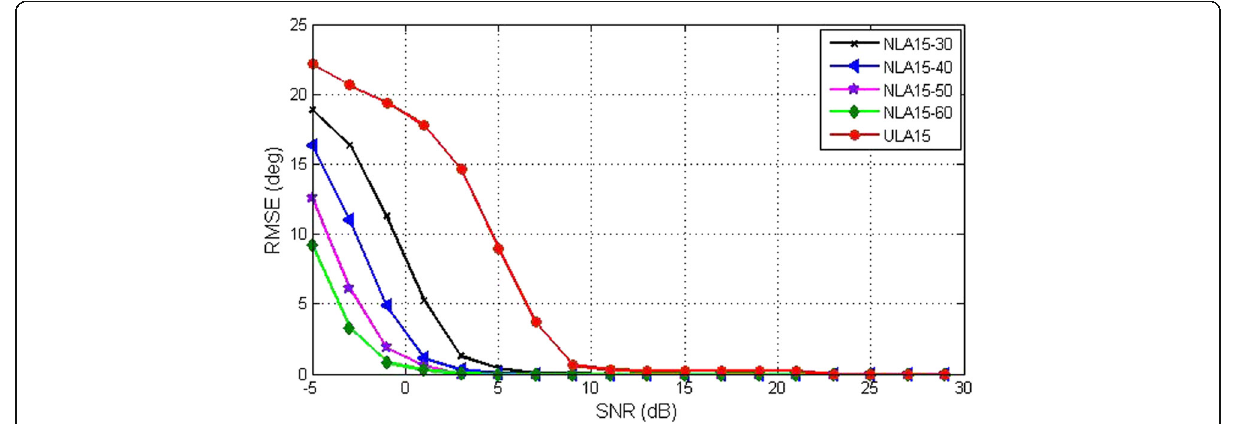
Fig. 9 The role of aperture length in DOA estimation with NLAs using proposed